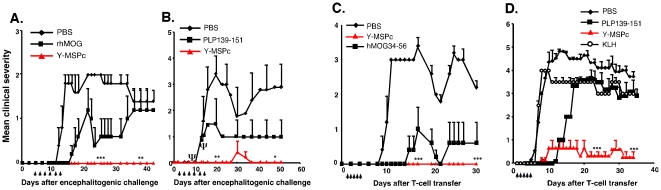
Systemic administration of Y-MSPc suppresses “classical” EAE induced by a single encephalitogenic antigen/peptide more effectively than peptide administration.(A, B), Suppression of actively induced EAE by Y-MSPc vs. specific antigen/peptide. BSF1 mice were immunized for induction of EAE by rhMOG (A) or PLP139-151 (B). On days indicated by arrows, the mice (n = 5 per group) received i.v. injection of soluble rhMOG (75 µg), PLP139-151 (75 µg), or Y-MSPc (75 µg) in 0.5 ml PBS, or PBS alone. Ψ, denotes mortality in the PLP139-151 treated group (Fig. 2B) due to anaphylactic shock on days 9 and 11 after immunization (one mouse and two mice, after the third and fourth injections, respectively), and therefore from day 11, the data are given for the two remaining mice only. (C, D), Suppression of passive EAE by Y-MSPc vs. specific peptide. EAE was passively transferred in naïve BSF1 mice with phMOG34-56-specific (C) or phPLP139-151-specific (D) line T cells (2×106 cells). From days 1 to 5 (arrows), the mice (n = 6 per group) were injected i.v. with 75 µg of hMOG34-56, PLP-139-151, Y-MSPc, or KLH in 0.5 µl PBS, or with PBS alone. Shown are the clinical scores of one experiment out of two independent experiments that were performed of suppression of active (A, B) and passive (C, D) EAE. The two independent experiments yielded similar results, and the propensity of PLP peptide to induce high frequency of fatal anaphylactic shock was observed in the two experiments, as previously reported [52]. *, p<0.05; ** , p<0.005; ***, p<0.0005, compared to PBS control group; two tailed unpaired Student's t-test.